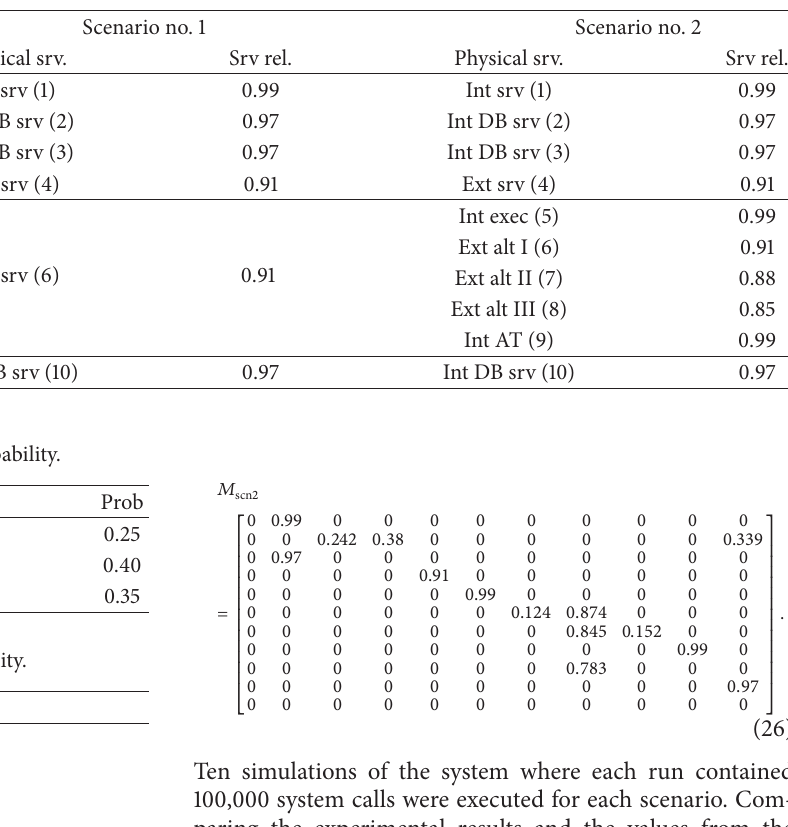
Table 1: Service configuration.